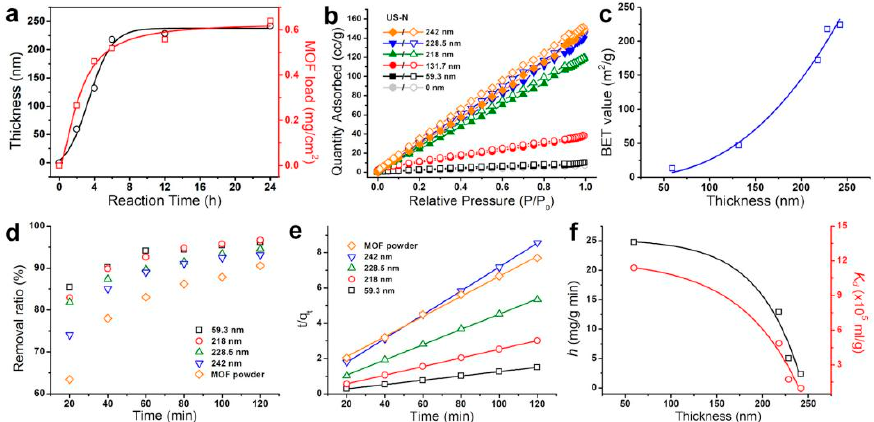
Figure 2. ( a ) MOF layer thickness and MOF load of US-N with different reaction times, ( b ) the nitrogen adsorption isotherms of US-Ns with different MOF layer thickness, ( c ) BET surface areas of US-Ns with different MOF layer thickness, ( d ) the Hg 2+ removal performance of US-Ns with different MOF layer thickness, ( e ) pseudo-second-order kinetic models, ( f ) the initial sorption rate h (left, black) and the distribution ratio K d (right, red) versus layer thickness.